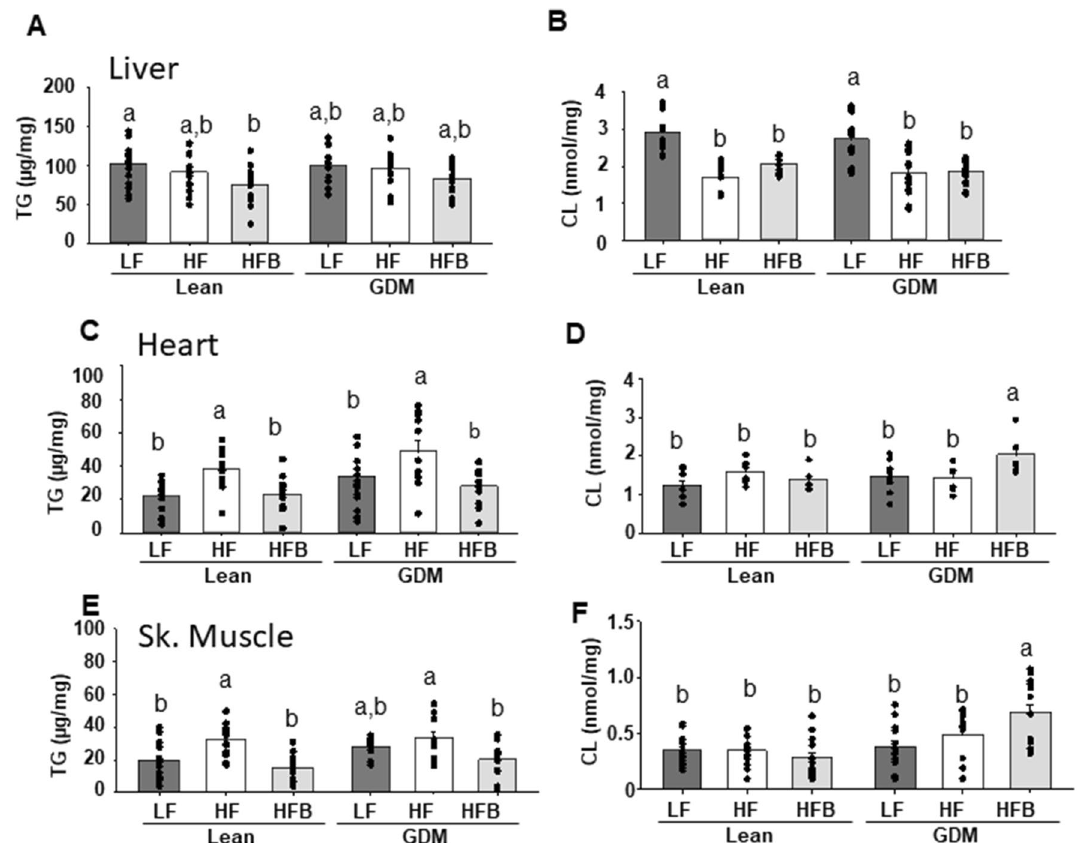
Figure 1. Triacylglycerol (TG) and total cardiolipin (CL) levels in liver, heart and skeletal muscle. All measurements were obtained following 12 weeks of the indicated diet (LF, HF, HFB). Values are means ± SEMs (n = 5–15). Means without a common letter differ, p < 0.05. GDM gestational diabetes